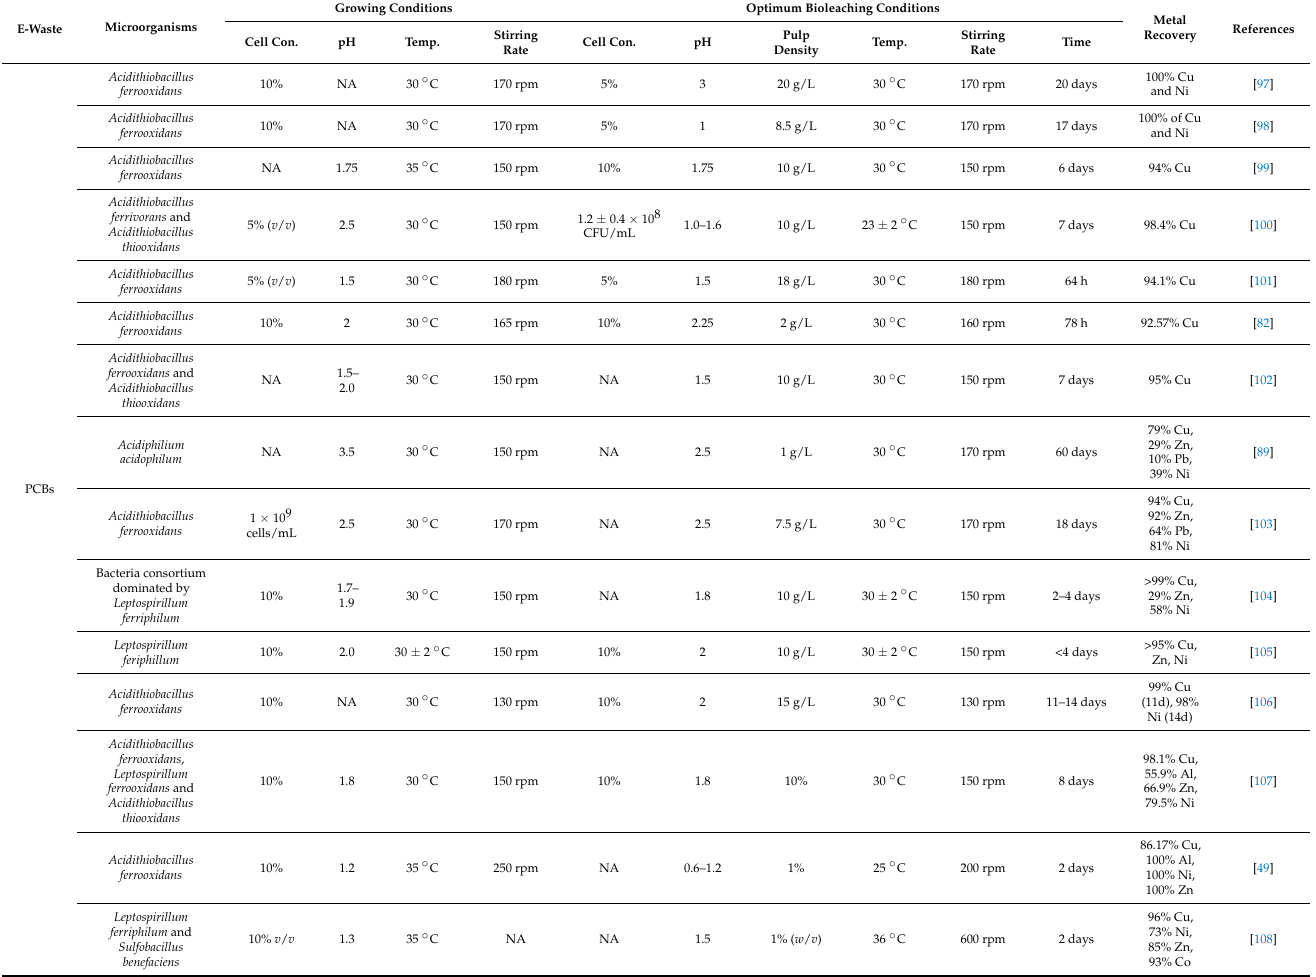
Table 2. A list of bioleaching studies on some selected e-wastes using mesophilic microorganisms their metal recovery aspects. (Note: Metals like Li, In etc. have been included, wherever applicable, to reflect the overall study along with base metal